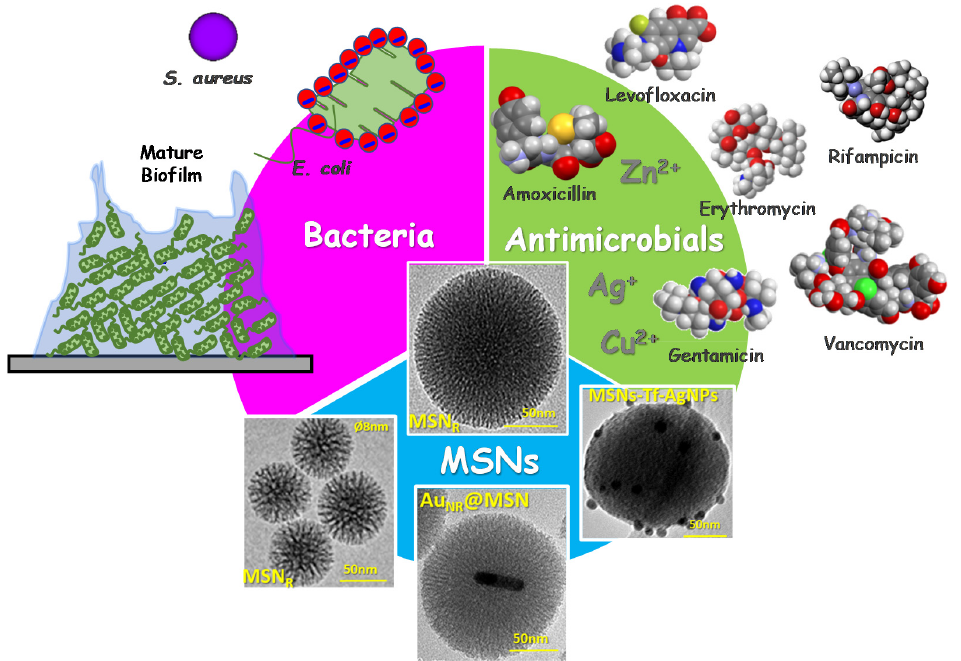
Figure 1. Schematic depiction of the three main actors starring in the innovative scientific approaches developed by professor Vallet-Regí’s research group in the design and engineering of nanoantibiotics for infection treatment: bacteria (in planktonic state or biofilms), antimicrobial agents (including antibiotics alone or in combination with metal ions) and mesoporous silica nanoparticles (MSNs). MSN R : Radial mesoporous silica nanoparticles; Au NR @MSN: gold nano-